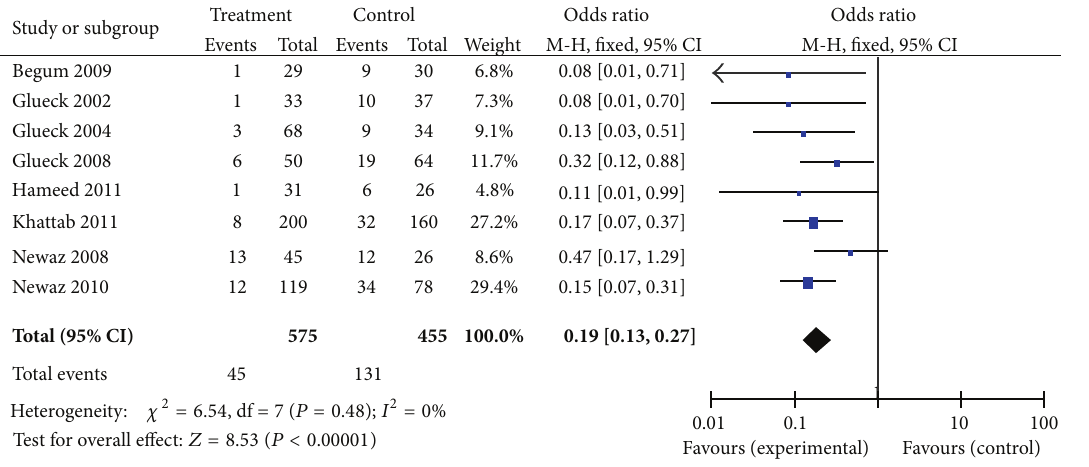
Figure3:Themeta-analysisoftheoddsratioforgestationaldiabetesinthestudieswithdisease-matchedcontrolsorpatients’selvesascontrol.